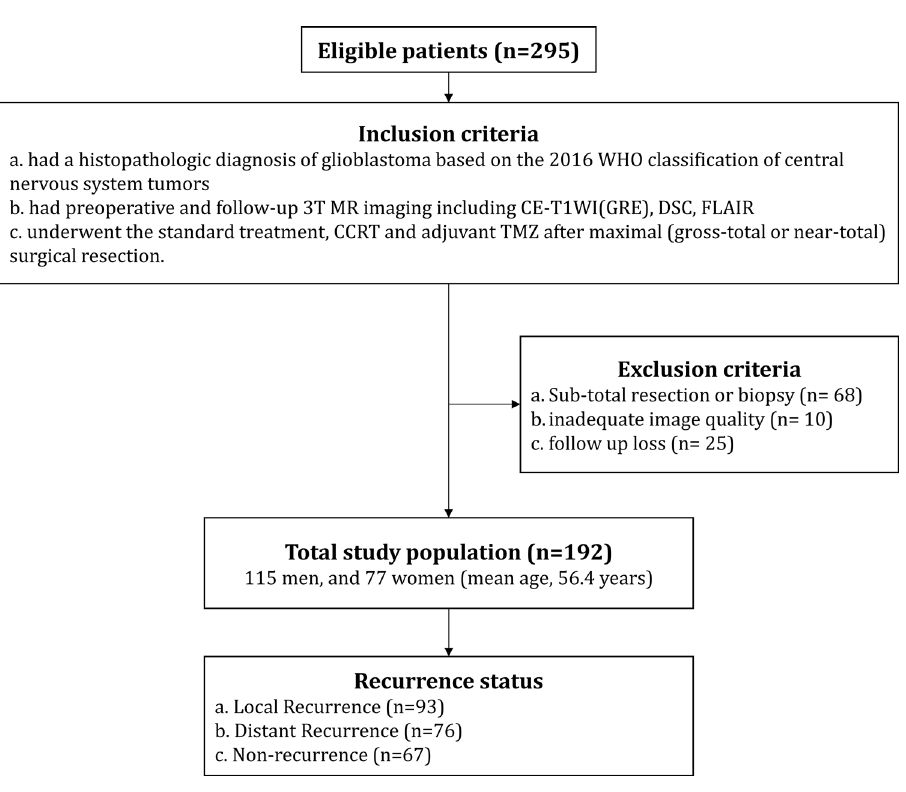
Figure 1. Patient inclusion/exclusion